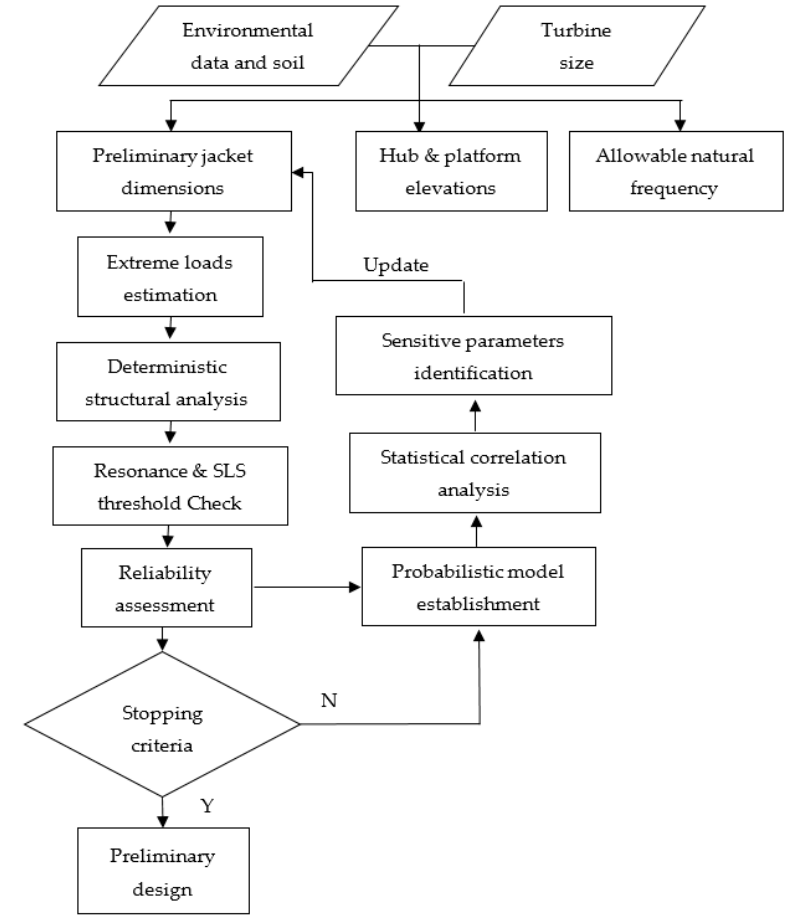
Figure 1. A flow chart for the proposed probabilistic preliminary design framework.